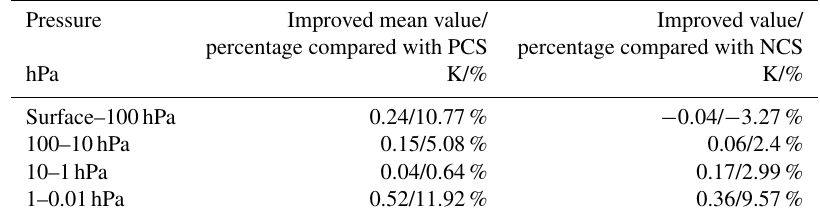
Table 1. The mean improvement value of the ICS and its percentages compared with the PCS and NCS at different